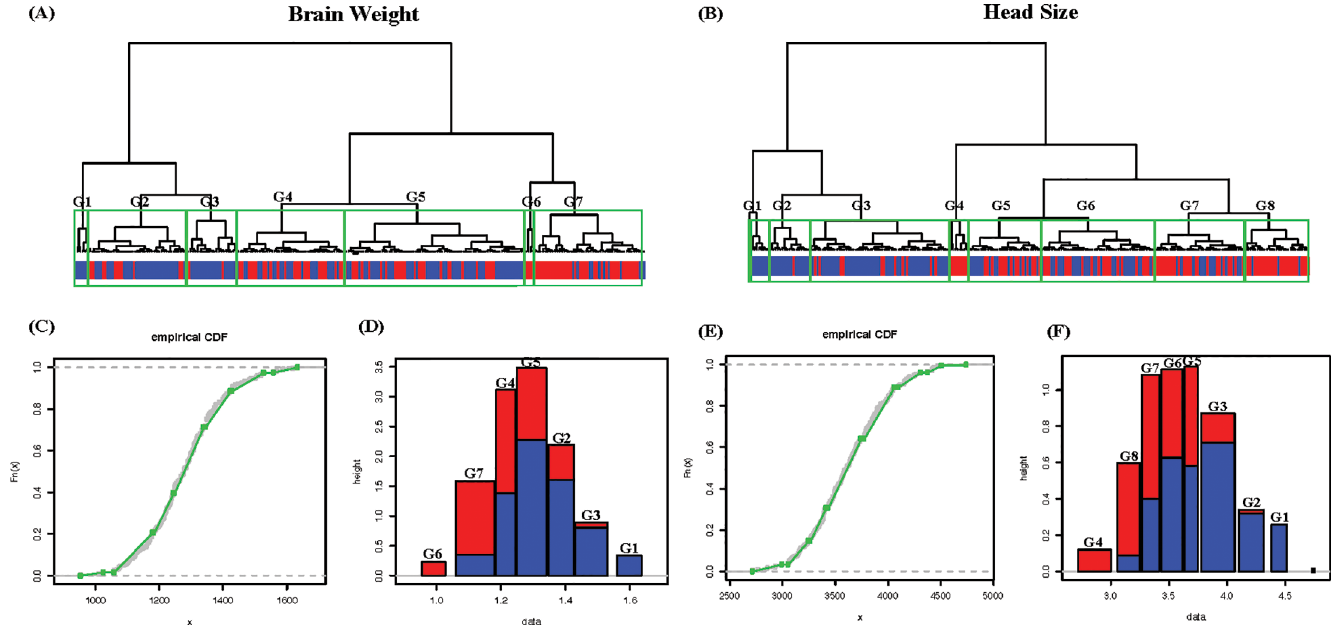
Fig 2. Two features’ hierarchical clustering trees and corresponding empirical distributions and possibly-gapped histograms. (A)Brain weight’s hierarchical clustering tree marked with 7 clusters; (B)Head size’s hierarchical clustering tree marked with 8 clusters; (C)The empirical distribution of head size superimposed with an 8-piece linear approximations showing with possibly-gaps; (D) The possibly-gapped histogram with 8 bins colored with gender proportions. (E)The empirical distribution of brain weight superimposed with a 7-piece linear approximations showing with possibly-gaps; (F) The possibly-gapped histogram with 7 bins colored with gender proportions. It is noted that the both histograms in (D) and (F) have two visible gaps separating the far-left and far-right bins. This is the strong evidence of dependency between these two features. The Red color code is for female and Blue for male.